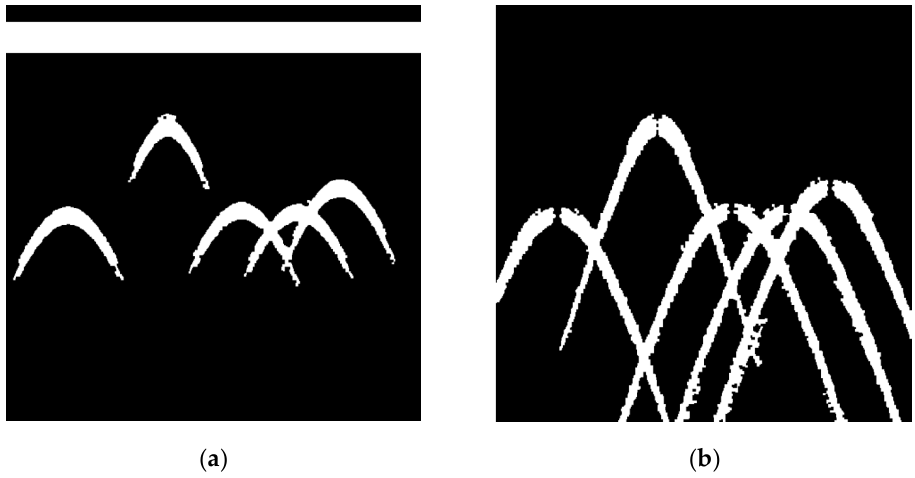
Figure 7. Longitudinal and transverse gradient graphs after denoising by the connected component analysis. ( a ) The longitudinal gradient graph. ( b ) The transverse gradient graph.